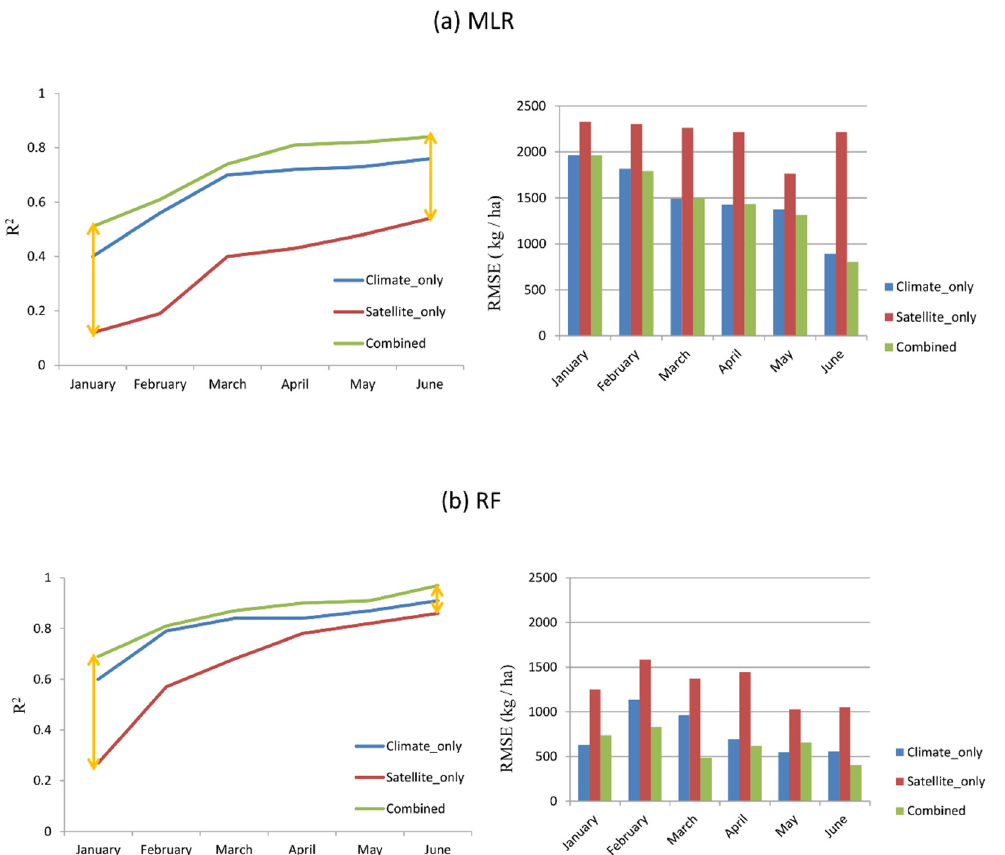
Figure 6. Cumulative input effect on the model performance. In each set of figures, the left figure represents the changing trend of R 2 with the increase of inputs; the figure on the right shows the changing trend of RMSE.